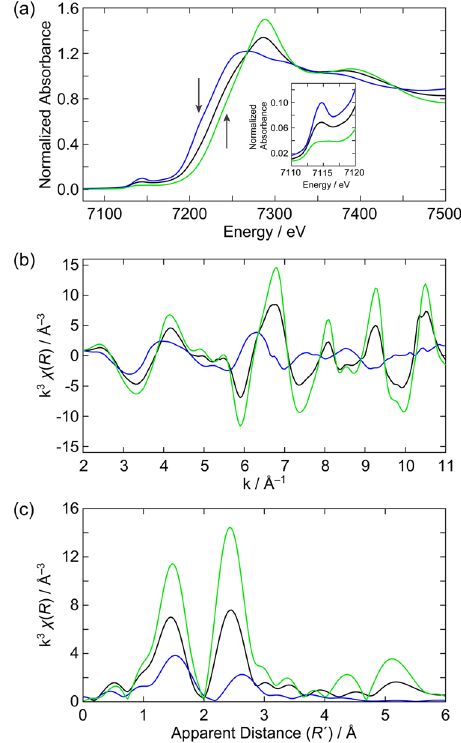
Fig. 3 X-ray absorbance spectra of CoFeO x . a Fe K-edge X-ray absorbance spectra and corresponding b k-space and c R-space for CoFeO x with the composition 50% Fe:50% Co (black line), and calculated Fe 3 + (blue line) and Fe 4 + spectra (green line). Inset of a highlights the pre-edge structure (XANES) spectra and the k-space and R-space data are given in Fig. 3 for CoFeO x with a 50% Fe:50% Co (black line)